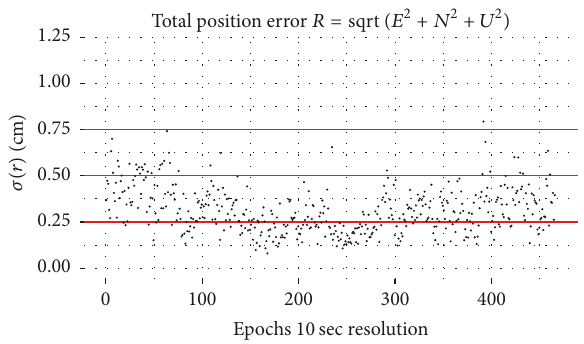
Figure18:Standarddeviationoftheroverpositionerror.Horizontal lines are threshold values. Baseline of ∼ 1km, year: 2013, DOY: